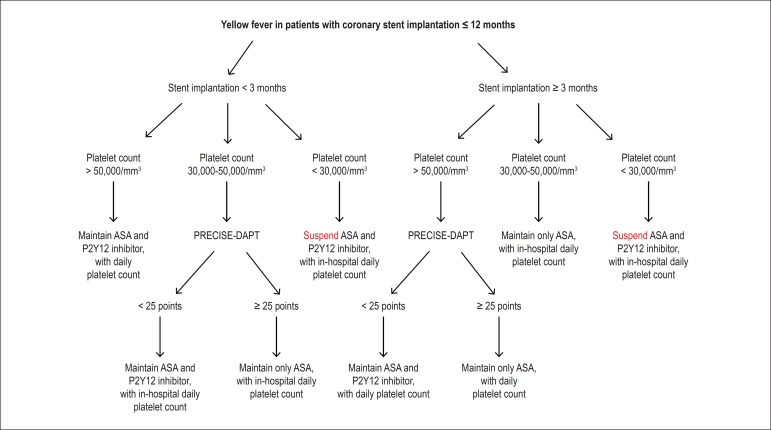
Algorithm for the management of antiplatelet drugs in patients with coronary
stents implanted within less than 12 months and yellow fever with neither
active bleeding nor blood dyscrasia signs. ASA: acetylsalicylic acid.